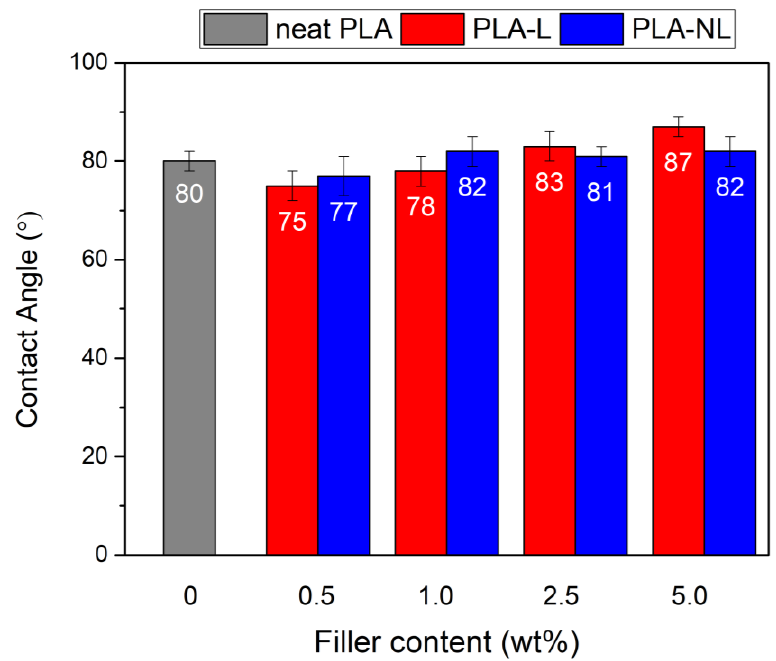
Figure 17. Contact angle of neat PLA and PLA – Lignin/Nanolignin composites.